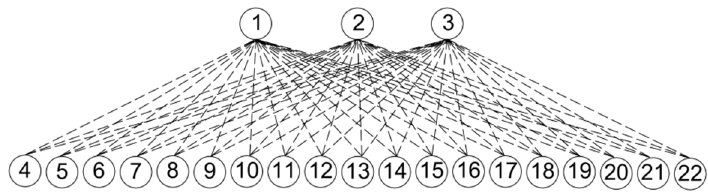
Figure 3. Bipartite graph of the case